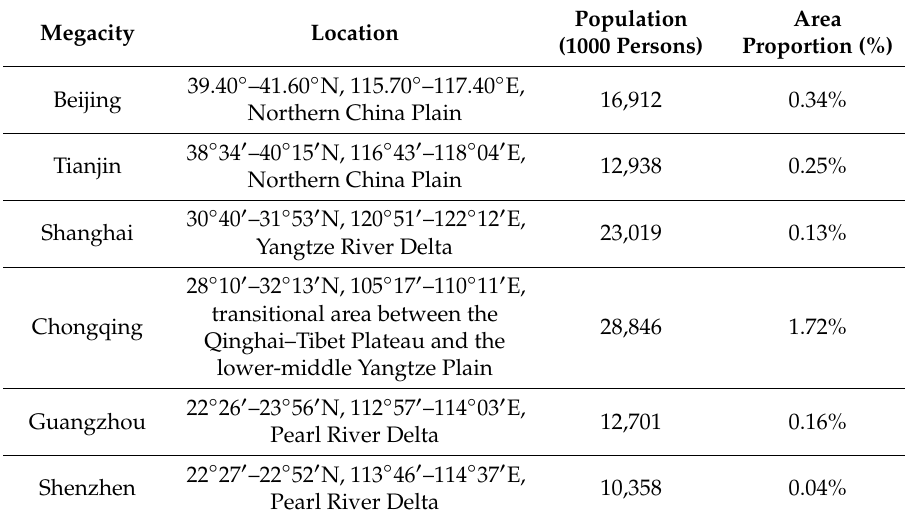
Figure 1. Locations of China’s six megacities and their urban lands during 2000–2018: ( a ) Beijing, ( b ) Tianjin, ( c ) Chongqing, ( d ) Shanghai, ( e ) Guangzhou, and ( f ) Shenzhen. Table 1. Basic information of China’s six megacities.